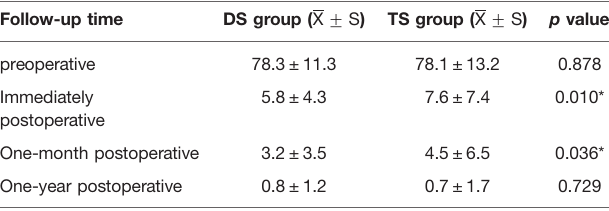
TABLE 4 | Comparison of ODI between DS group and TS